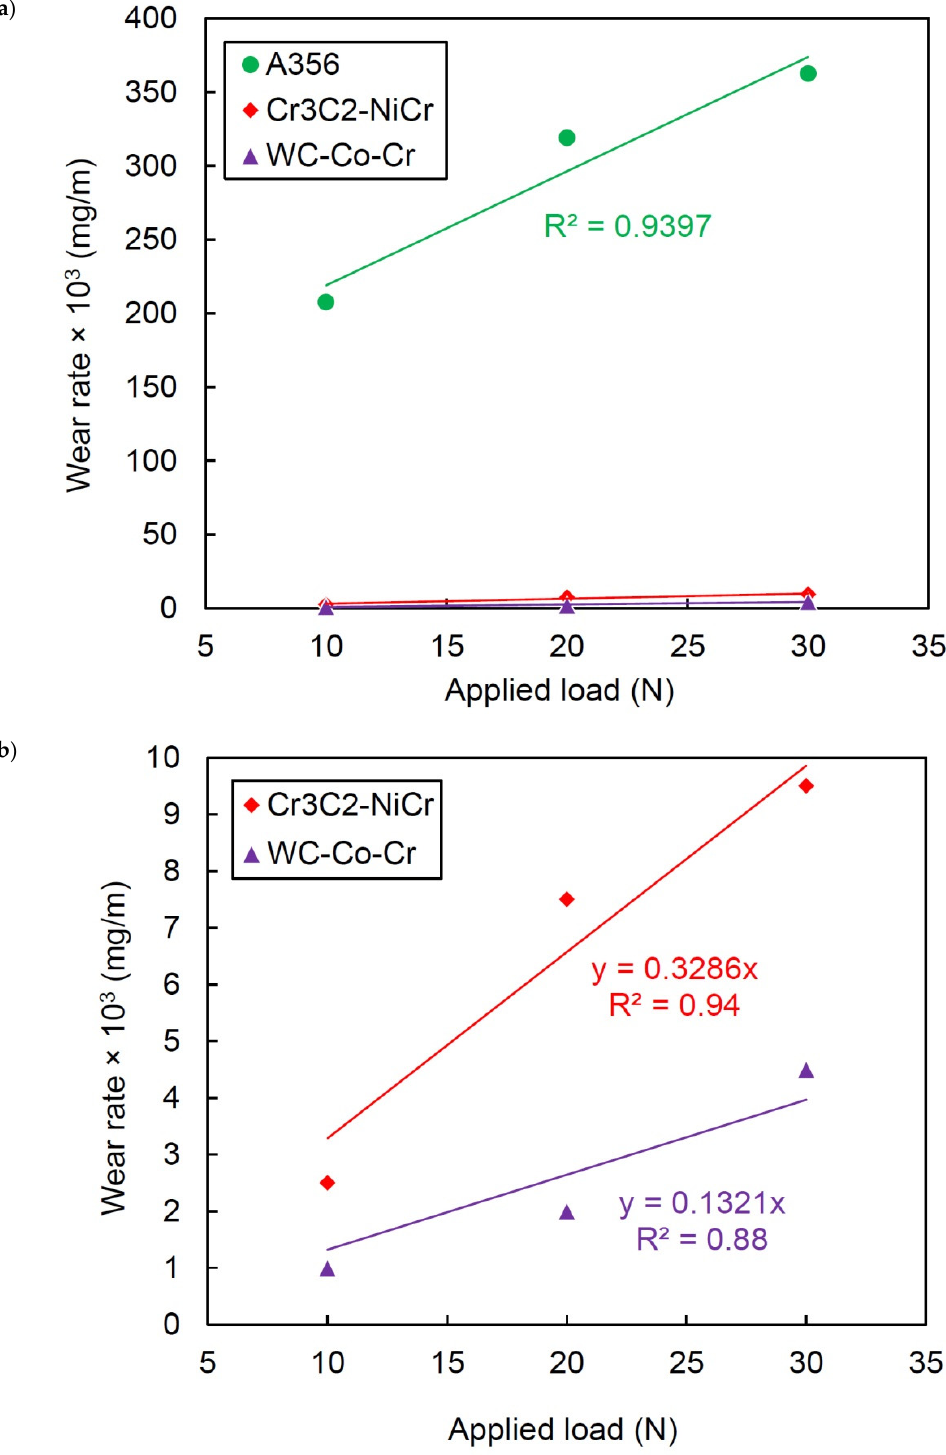
Figure 8. ( a ) Archard’s relationship between applied load and wear rate of A356 substrate and coatings; ( b ) closer comparison of Cr 3 C 2 -NiCr and WC-Co-Cr coatings. coatings; ( b ) closer comparison of Cr 3 C 2 -NiCr and WC-Co-Cr